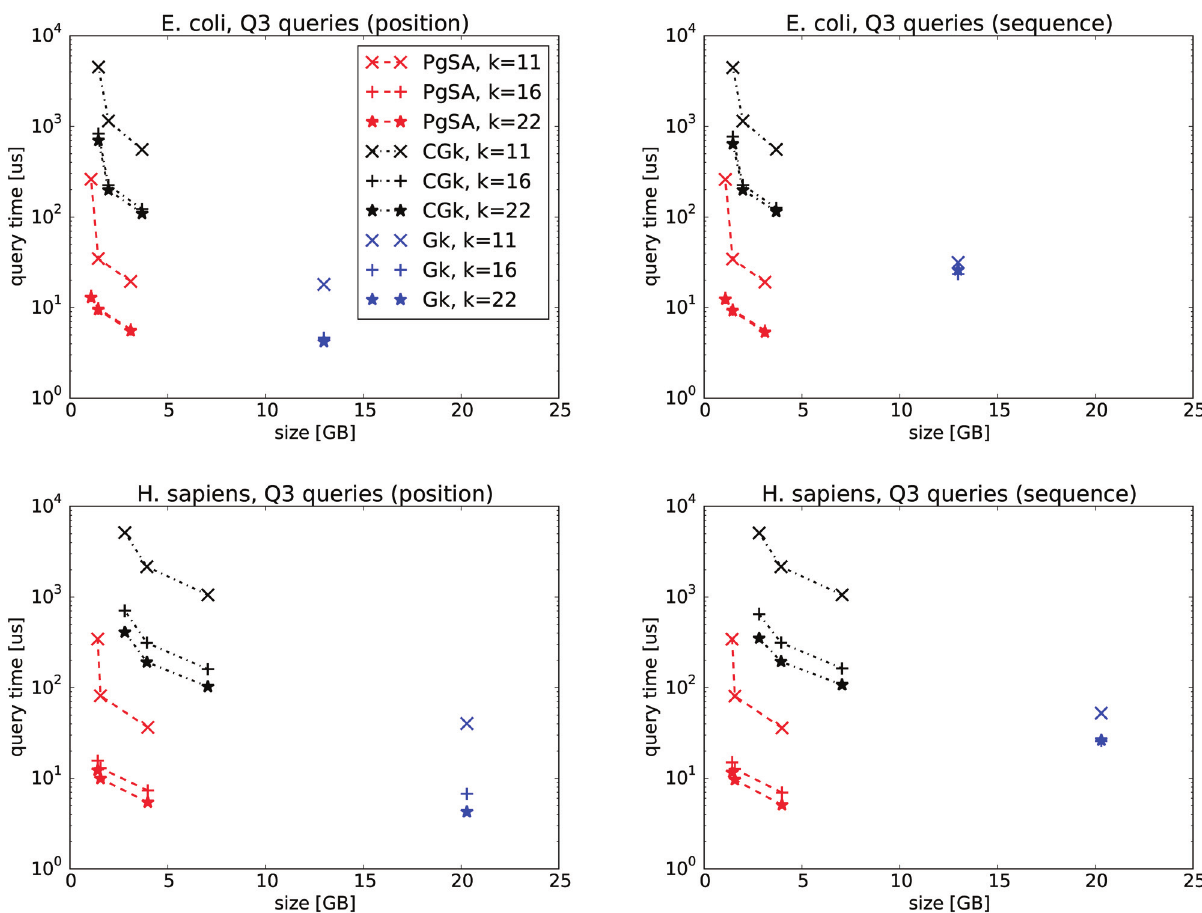
Fig 4. Q 3 query results on E. coli (top row) and H. sapiens (bottom row) datasets. The three points in PgSA series correspond to sparsity s = 6 for the leftmost point, s = 3 (E. coli) or s = 4 (H. sapiens) for the middle point and s = 1 for the rightmost point. The three points in CGk series correspond to sampling rates sr of 512, 25 and 6 (E. coli), and 512, 22 and 6 (H. sapiens), respectively. On the left figures the query is given as a position in the read list, while on the right ones as a